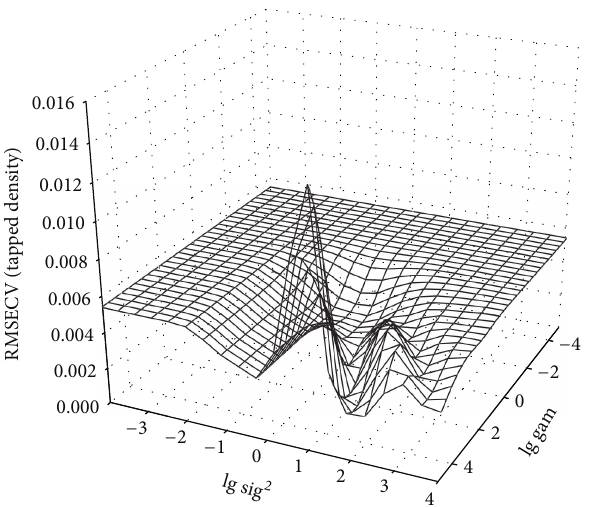
Figure 4: Hyperparameters optimization of the least squares sup- port vector machine model for tapped density. RMSECV represents the root mean square error of cross validation. Gam is the regu- larization parameter, and sig 2 is the Gaussian RBF kernel function